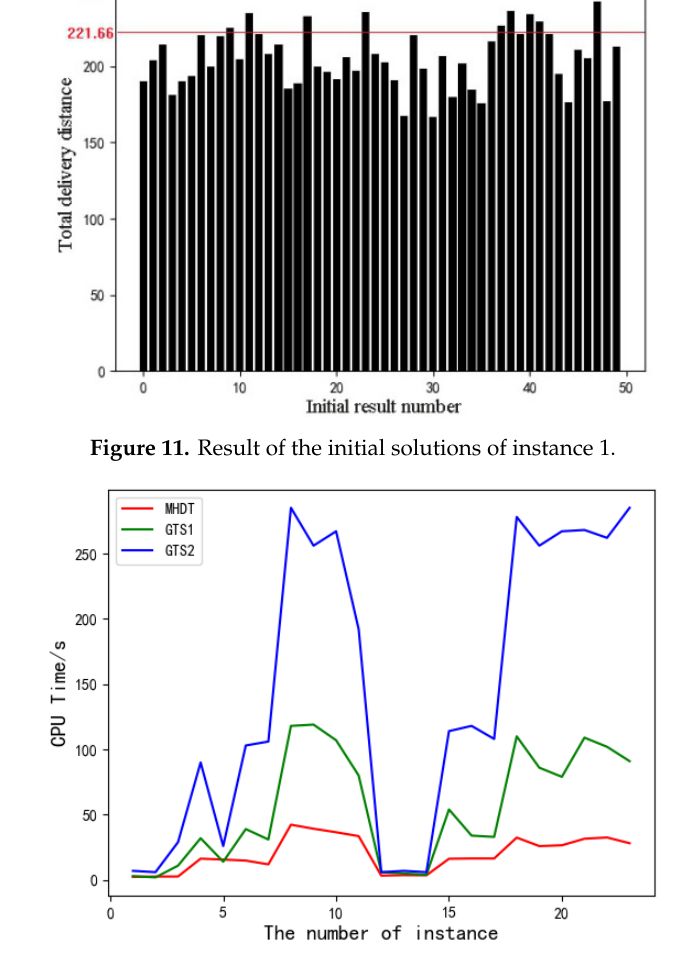
Figure 12. Among three algorithms about CPU time. Figure 12. among three algorithms about CPU time.